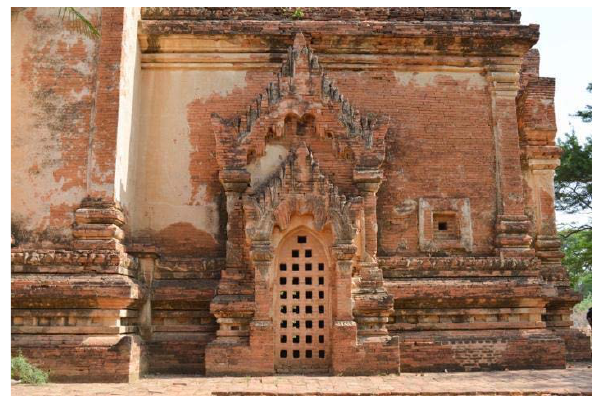
Figure 4. Remaining stucco on masonry